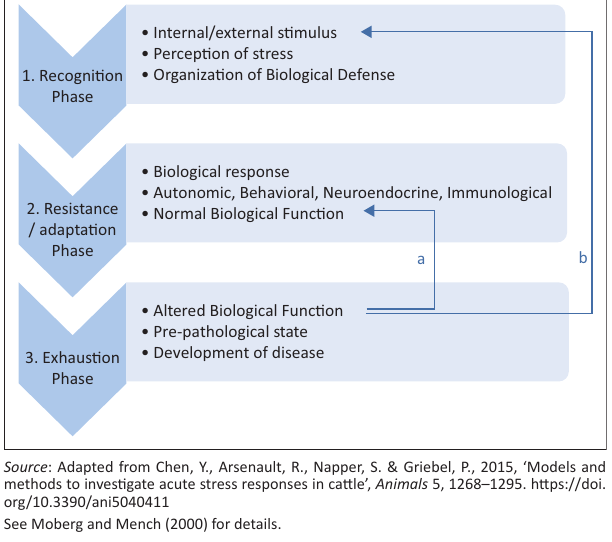
FIGURE 1: The stages involved in the biological general adaptation syndrome in response to stress in